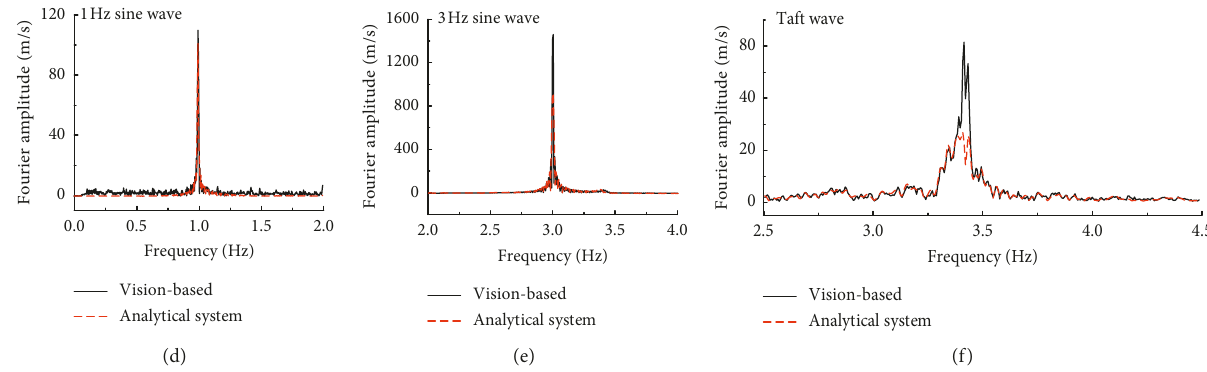
Figure 7: Comparison of the relative displacement of (a) 1 Hz sine wave, (b) 3 Hz sine wave, and (c) Taft wave and Fourier amplitude (d)